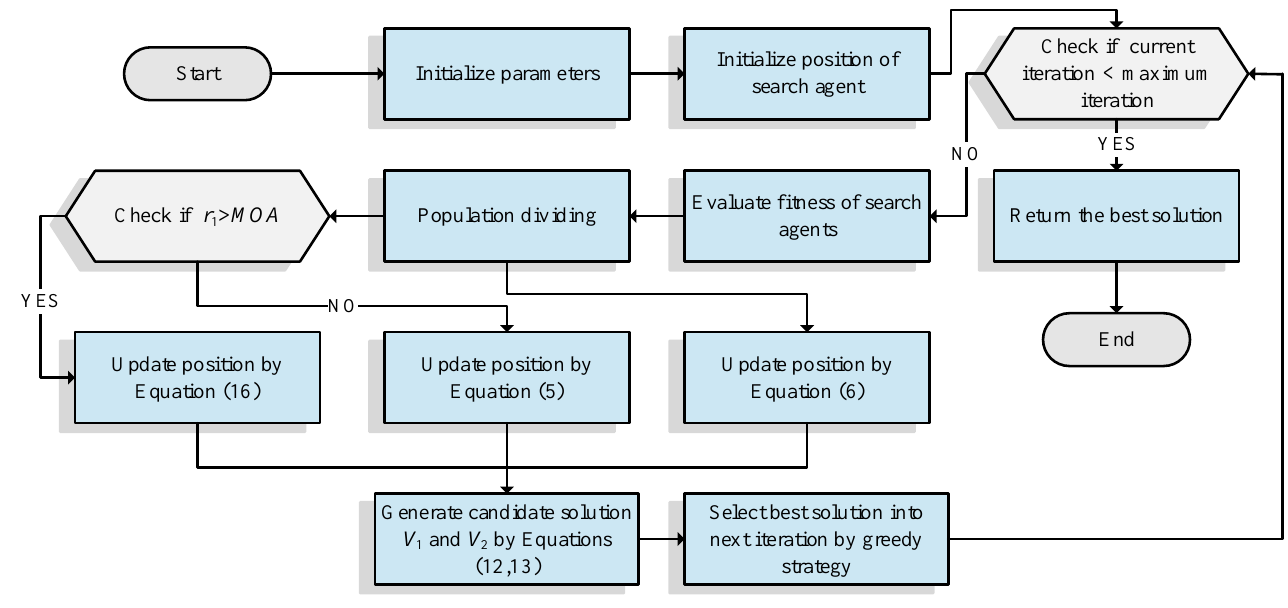
Figure 5. Flowchart of HAGSA.